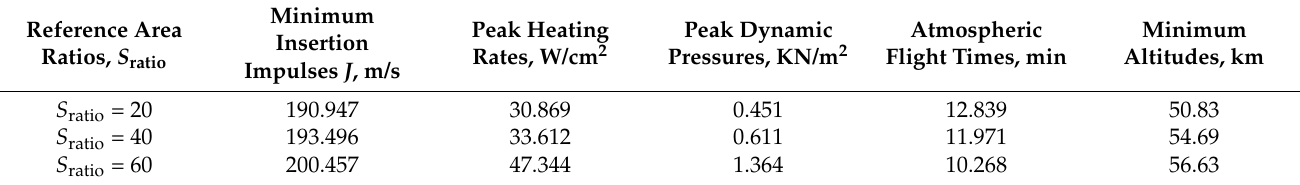
Table 5. Optimal results with different reference area